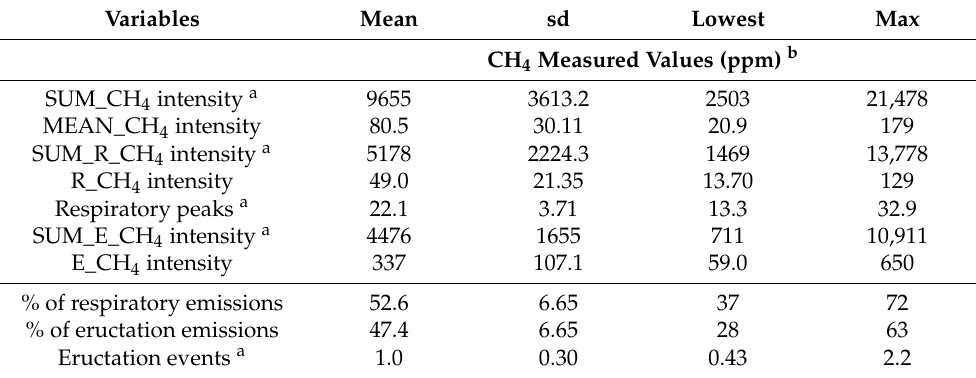
Table 1. Descriptive statistics of the CH 4 profiles obtained from the 55 dairy cows participating in the